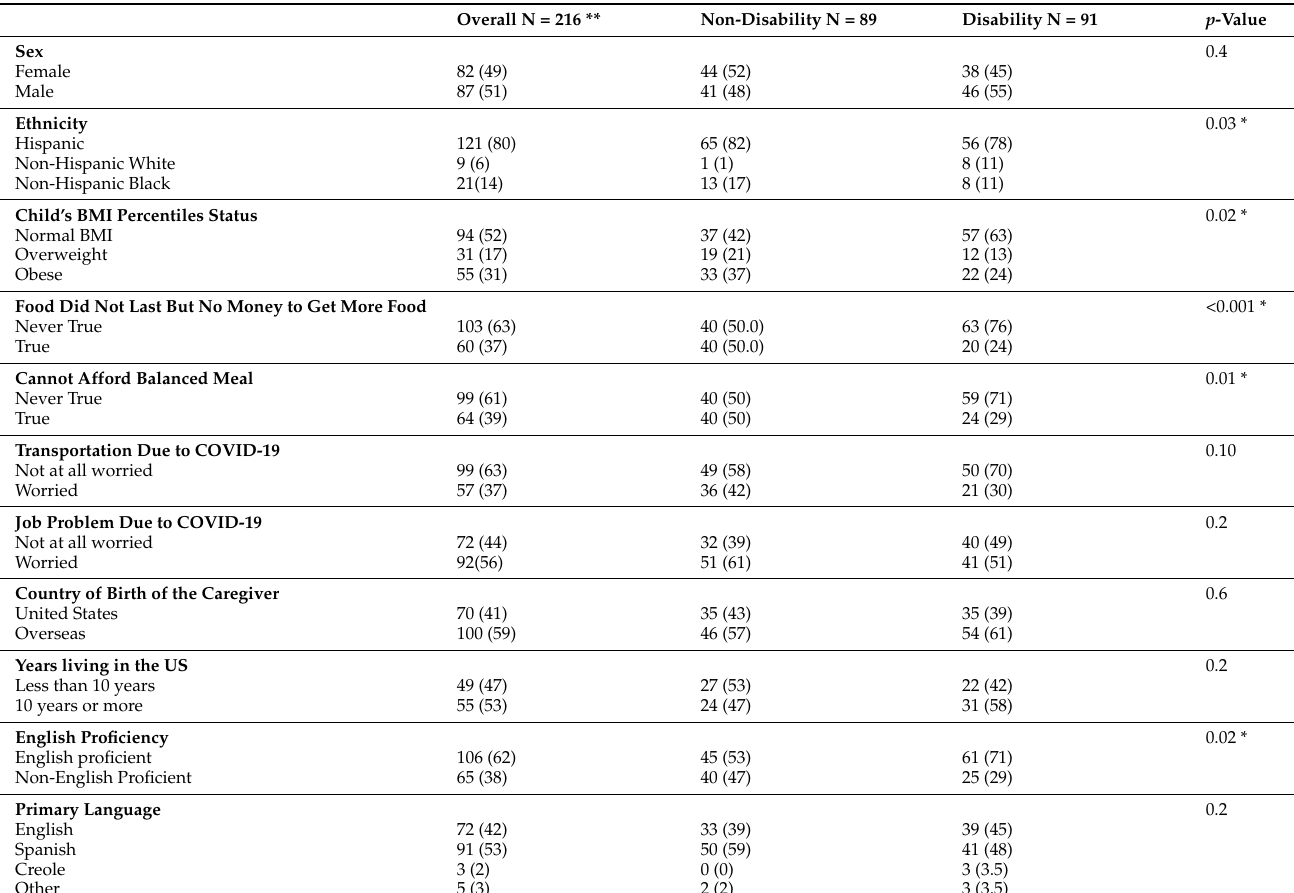
Table 1. Participant Descriptive and COVID-19 Pandemic-Related-Challenges by Disability